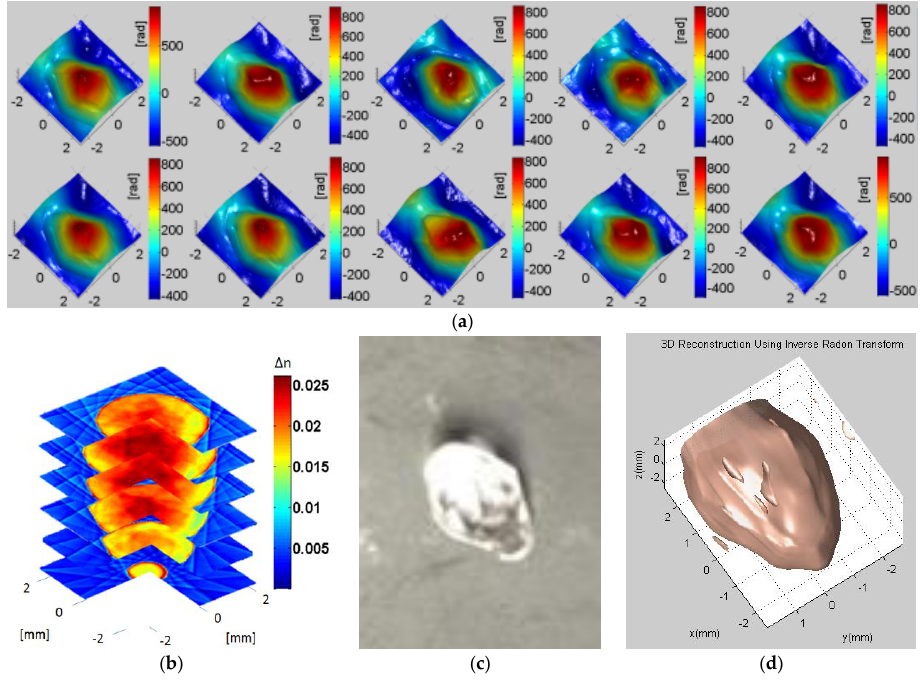
Figure 8. ( a ) The reconstructed phases using SLM based TIE system at 10 projections, lateral scale in mm; ( b ) slices of the 3D tomographically reconstructed diamond shaped bead; ( c ) photograph of the diamond-shaped bead; and ( d ) outer surface of the diamond-shaped bead.